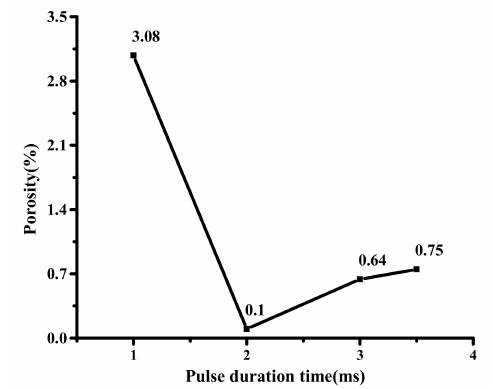
Figure 11. The porosity variation curve of the sealing layer under di ff erent pulse duration